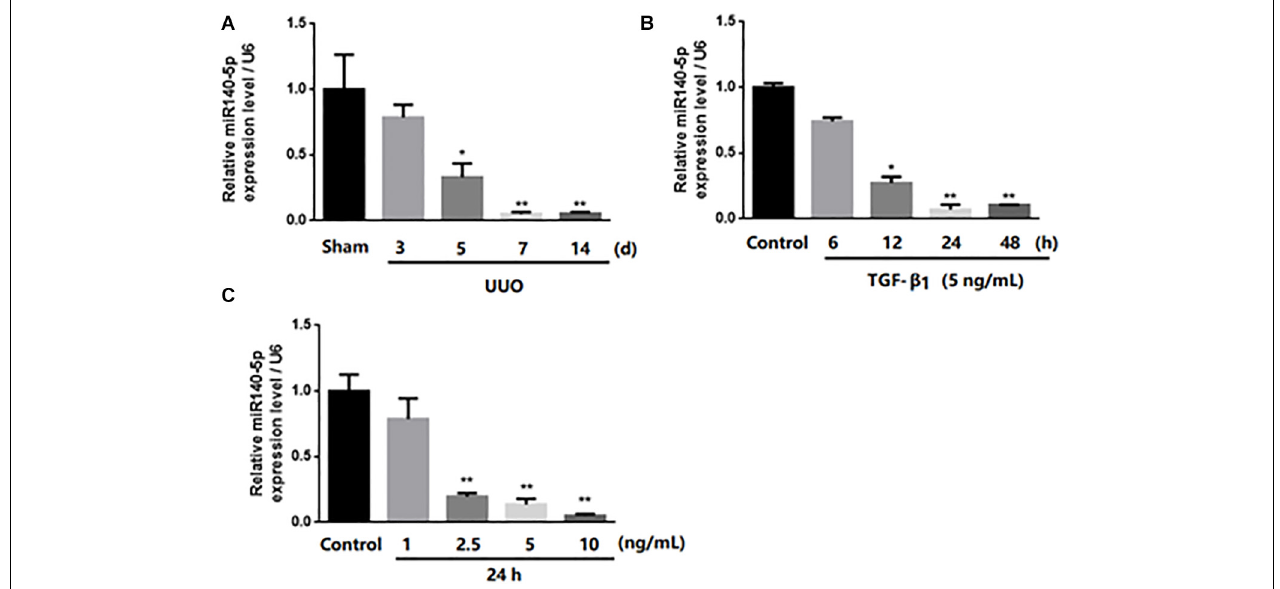
FIGURE 2 | Expression of miR-140-5p in UUO mice kidney and level of miR-140-5p in HK2 cells after TGF- β 1 treatment. (A) miR-140-5p expression of UUO mice kidney was determined by RT-qPCR at indicated time points after UUO treatment. (B) Time-dependent decrease of miR140-5p expression. Expression of miR-140-5p in HK2 cells exposed to 5 ng/ml TGF- β 1 treatment for 6, 12, 24, 48 h. miR140-5p level was determined by RT-qPCR. (C) Dose-dependent decrease of miR140-5p expression. HK2 cells were treated with different concentrations of TGF- β 1 for 24 h Data was presented as mean ± SD of three experiments. Control: no transfection treatment, Negative control (NC): cells transfected with scrambled oligonucleotide. ∗ P < 0.05 versus Control; ∗∗ P < 0.01 versus